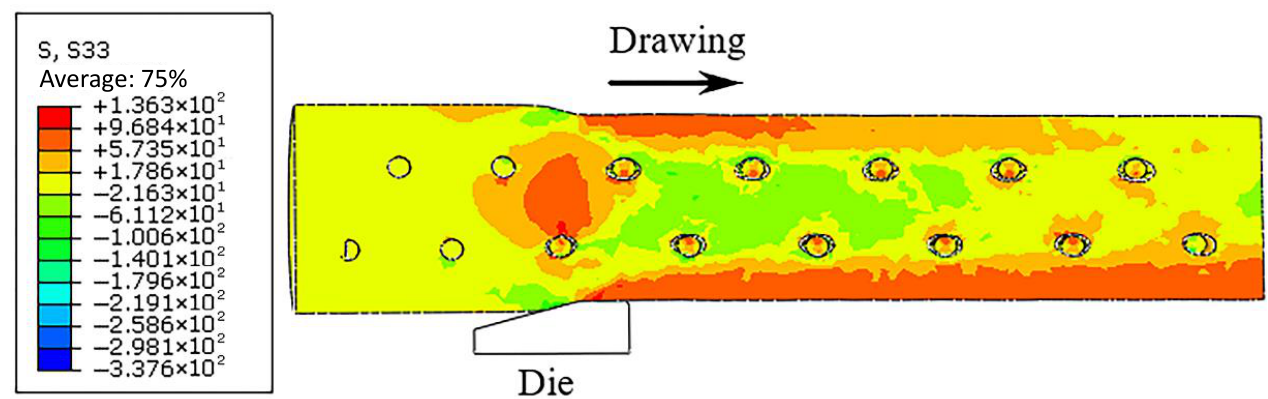
Figure 5. Stress distribution in